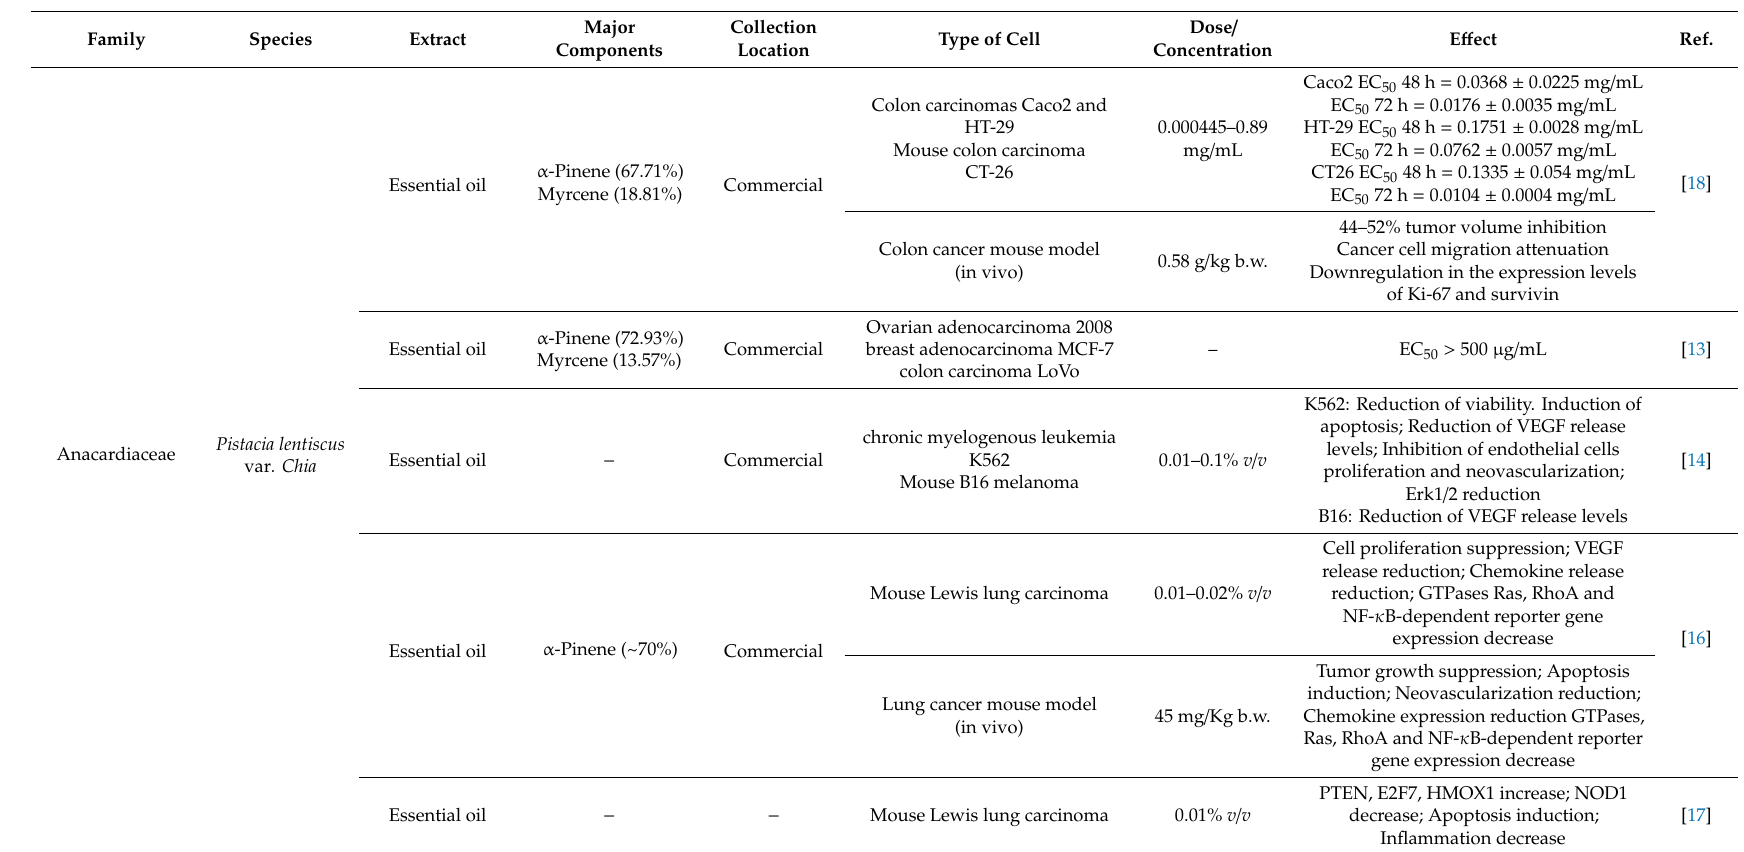
Table 1. Summary of the antiproliferative activity of extracts isolated from Greek aromatic plants. The cell lines are human unless otherwise stated. N.d. = not determined. ( − ) in major component and collection location columns indicates that the authors report no data on the major components and collection location, respectively. (–) in dose / concentration column indicates that the concentrations used were not